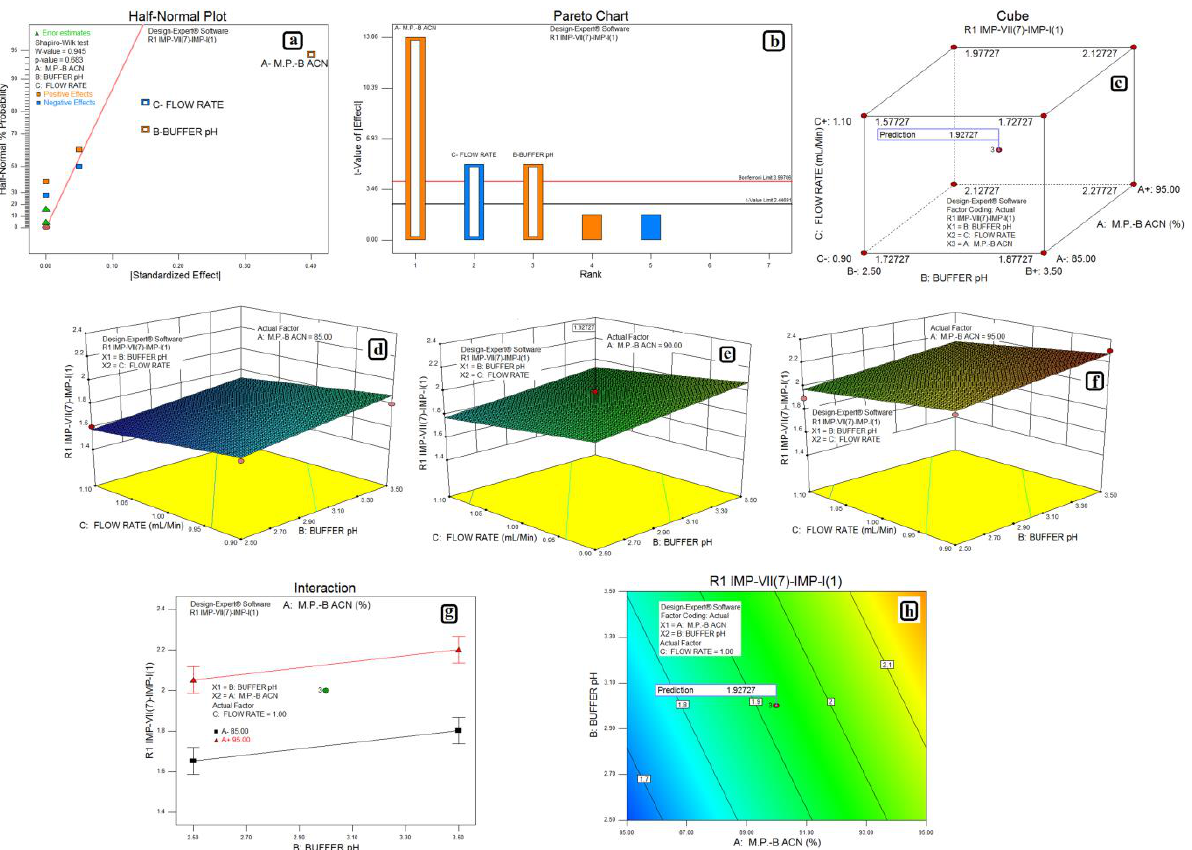
Figure 1. ( a ) Half-normal plot; ( b ) Pareto chart; ( c ) cube; ( d ), ( e ), and ( f ) 3D plots showing effect of % of acetonitrile (ACN) in mobile phase-B and pH of buffer on resolution R1; ( g ) effect on resolution R1 due to interaction between buffer pH and % of ACN in mobile phase-B; and ( h ) desirability of resolution between Impurity-VII ( 7 ) and Impurity-I ( 1 ) R1 .